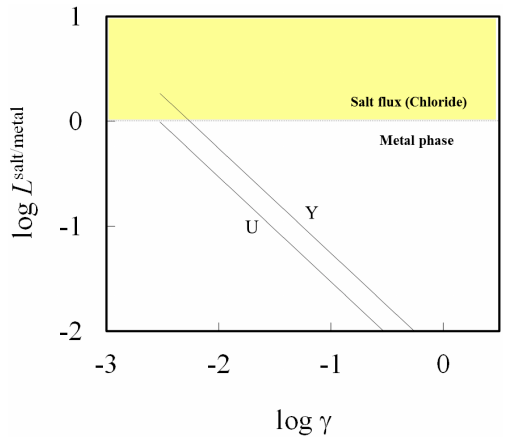
Figure 6. Effect of activity coefficient of chloride on element distributions (elements: U and Y) between metal and chloride phase at 1073 K using flux